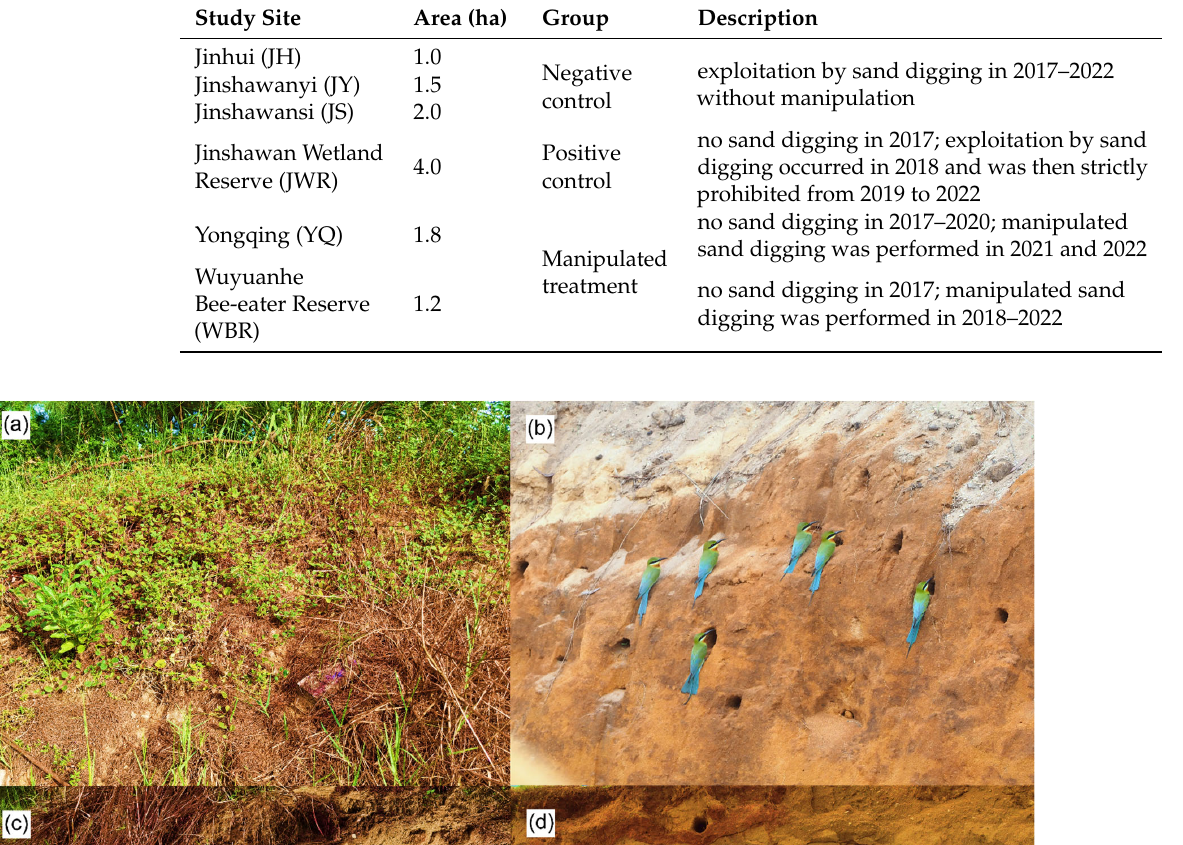
Table 1. Details of the six study sites from 2017 to 2022.